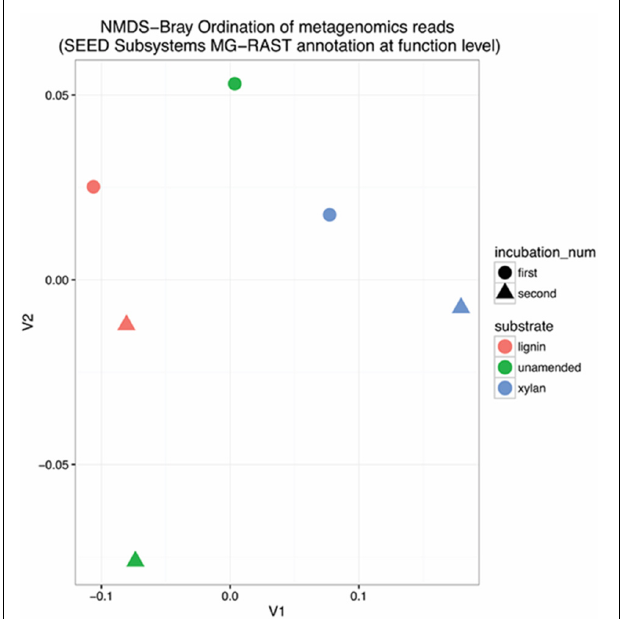
FIGURE 2 | Non-metric Multidimensional Scaling (NMDS) Bray Ordination of functional gene structure. Functional genes were characterized by shotgun DNA sequencing and compared using Bray–Curtis distance before NMDS. Stress was 3.25 × 10 − 14 . The substrate is indicated by the color in the ordination plot: red for lignin, green for unamended, blue for xylan. The incubation is indicated by the shape of the point: circle for the first incubation and triangle for the second